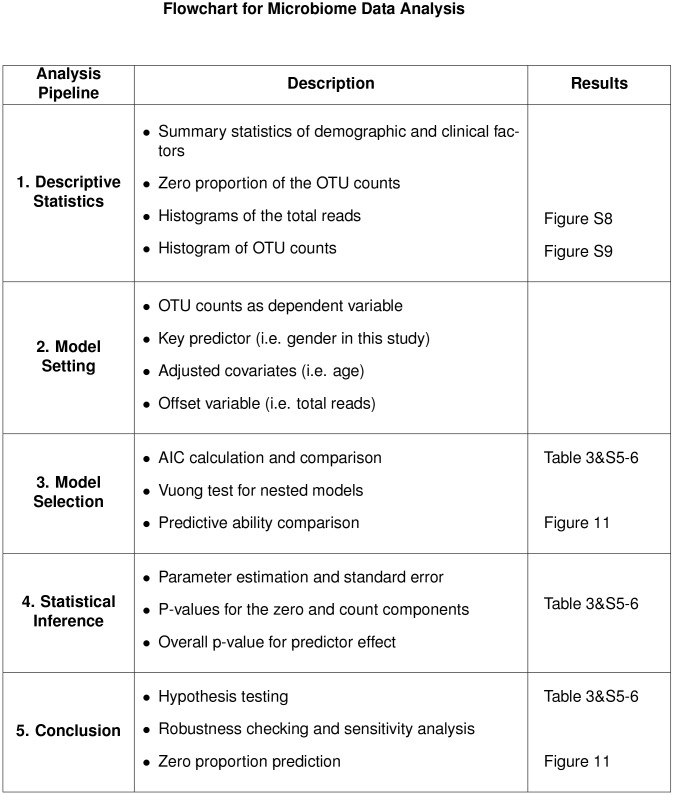
The flowchart for microbiome real data analysis.